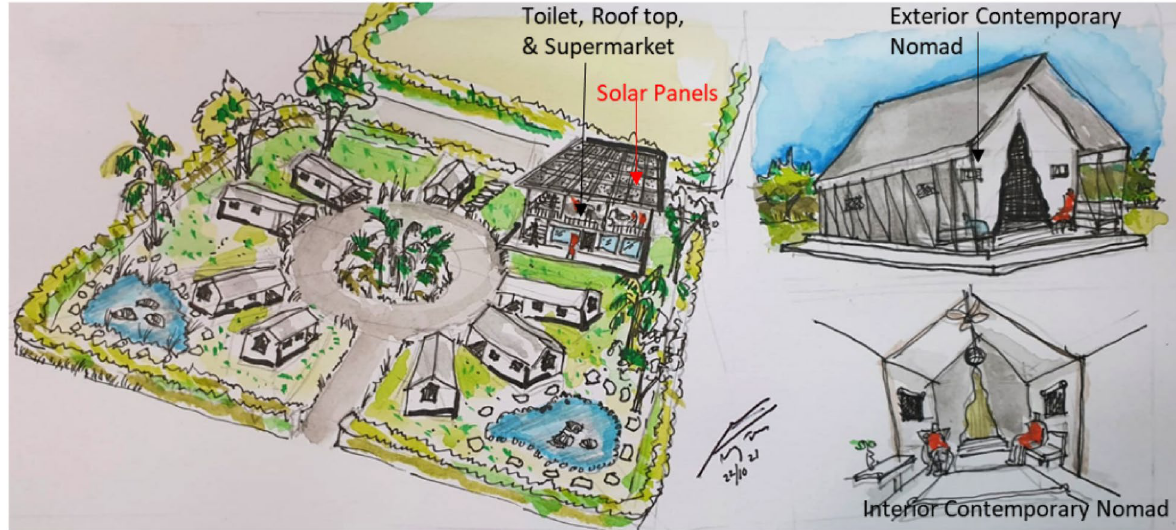
Fig. 1 Hotel with a system of Contemporary Nomad. Source: Authors